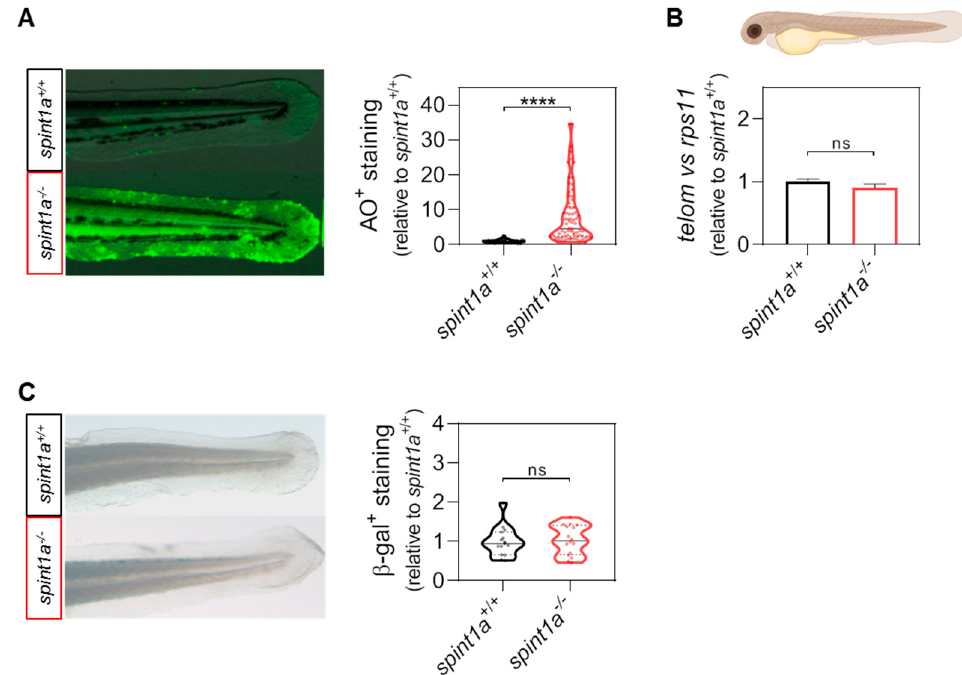
Figure 1. Spint1a-deficient zebrafish larvae do not show premature aging at 3 dpf. ( A ) Representative images and quantification of the cell death levels by acridine orange (AO) staining assay in the tail of wild type (wt) and Spint1a-deficient larvae. The violin plots with the median shown as a horizontal line show the distribution of AO + staining and are overlaid with the raw data, where each dot represents an individual. ( B ) The telomere length was measured in whole zebrafish larvae by qPCR using 40 ng of gDNA and determined as the telomere content relative to the single copy gene rps11. The graph shows the mean ± SEM of 25 pooled larvae ( n = 25) and triplicate samples from 2 independent experiments ( n = 2). ( C ) Quantification of the cellular senescence levels by senescence- associated b-galactosidase (SA b-gal) staining assay in the tail of wt and Spint1a-deficient larvae. The violin plots with the median shown as a horizontal line show the distribution of b-gal + staining and are overlaid with the raw data, where each dot represents an individual. ns, non-significant; **** p < 0.0001, according to unpaired t -test with Welch’s correction ( A ) and unpaired t -test ( B , C ). Scale bars, 400 μ m.